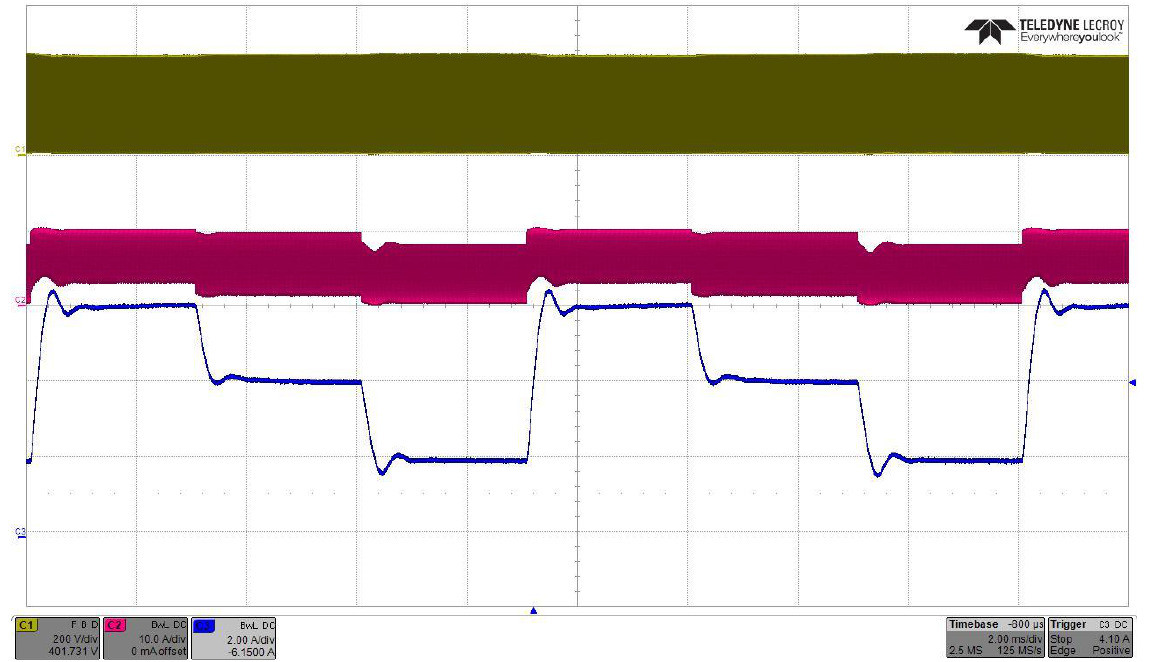
Figure 16. Response of the proposed SMC during step changes of the input current from 0 A to 6 A and from 6 A to 4 A and 2 A. (load voltage (yellow), load current (purple) and input/EMA current (blue)).